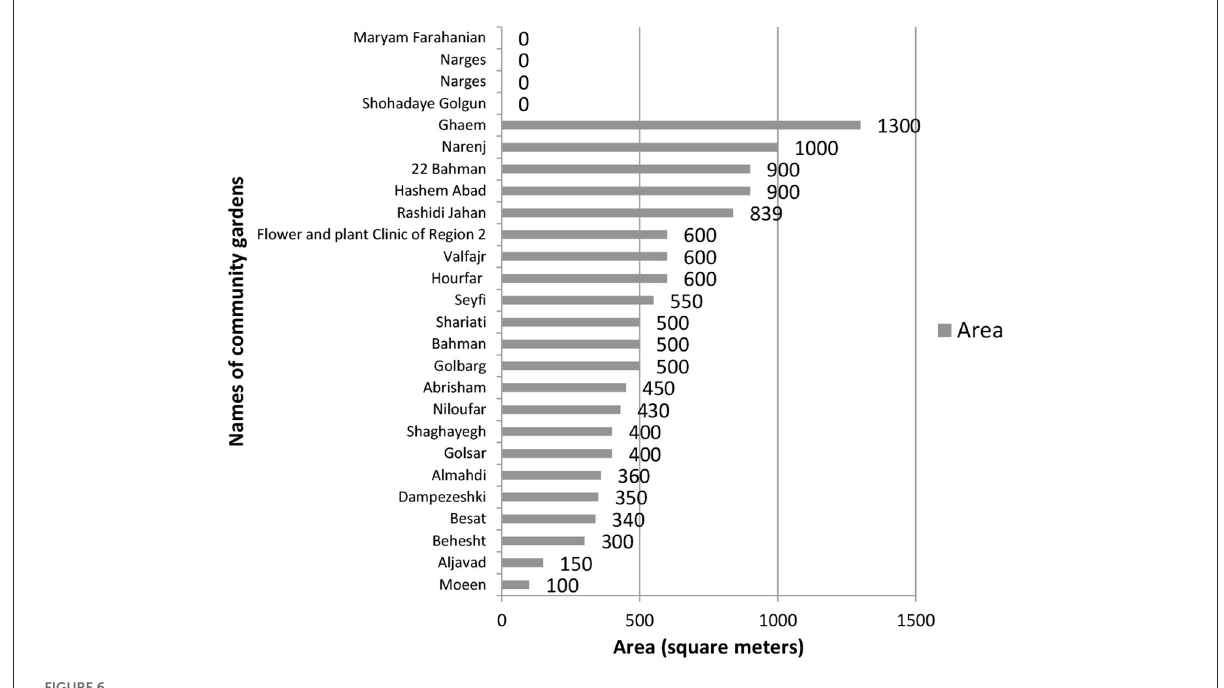
FIGURE6 Total area of